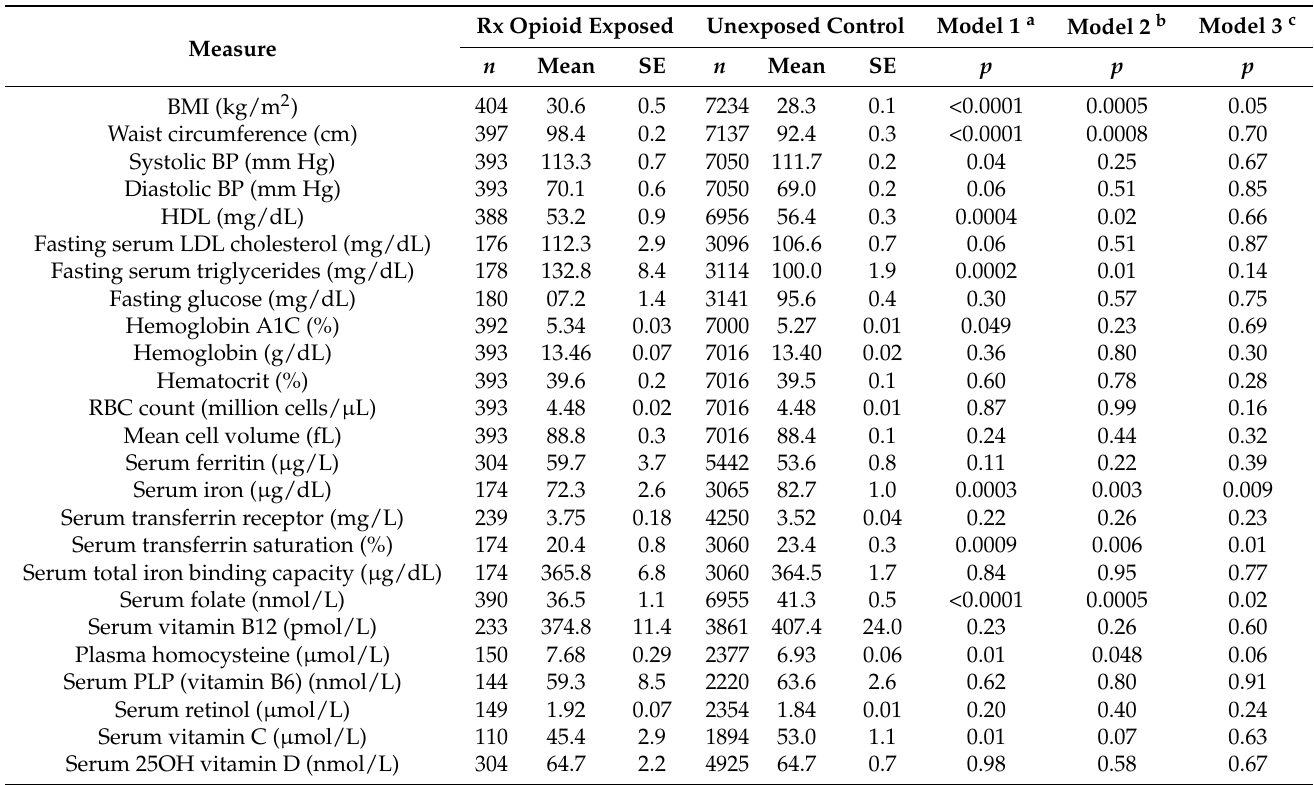
Table 2. Cardiovascular, metabolic, hematologic, and micronutrient status measures in reproductive age women by prescription opioid status, NHANES